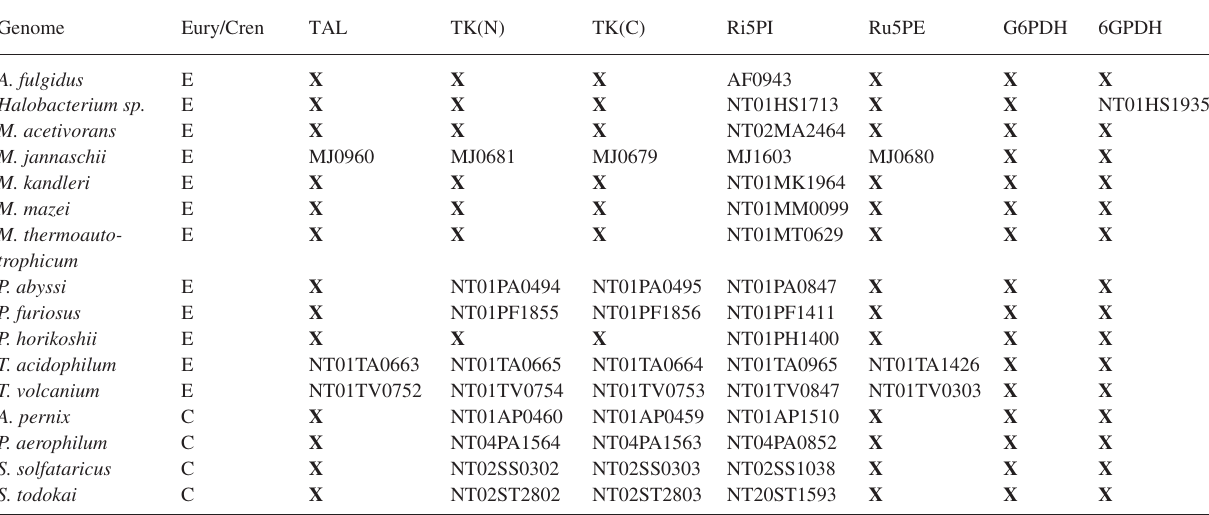
Table 1. Distribution of putative genes for pentose phosphate enzymes across the completed archaeal genomes in the TIGR database (http:// www.tigr.org/tigr-scripts/CMR2/CMRHomePage.spl). Column 2 specifies whether the organism belongs to the Euryarchaeota or Crenarchaeota. Gene designations refer to TIGR locus numbers. The letter X denotes a genome that does not have a putative gene. Abbreviations: TAL = transaldolase; TK(N) = transketolase, N terminal subunit; TK(C) = transketolase, C terminal subunit; Ri5PI = ribose-5-phosphate isomerase; Ru5PE = ribulose-5-phosphate-3-epimerase;G6PDH = glucose-6-phosphatedehydrogenase;and 6GPDH =